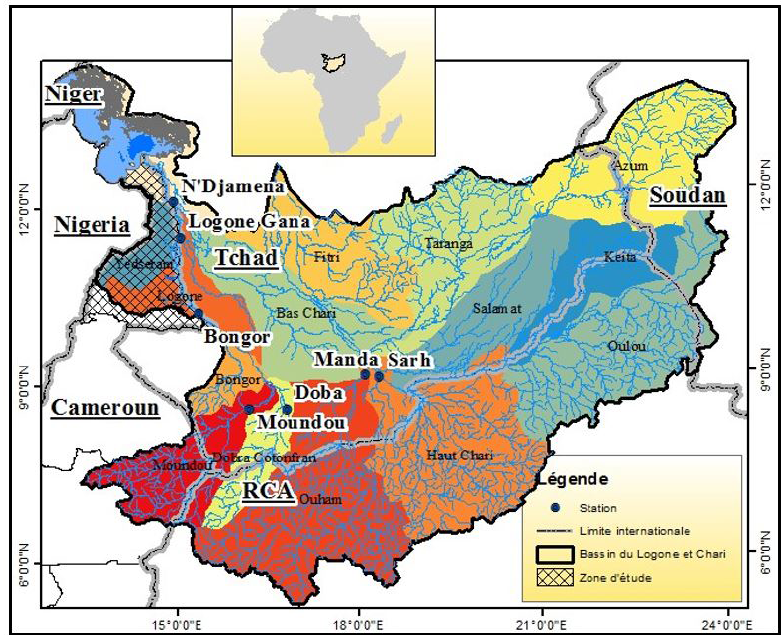
Figure 1. La région de l’Extrême-Nord du Cameroun dans le bassin du Logone-Chari (© CBLT, 2010).